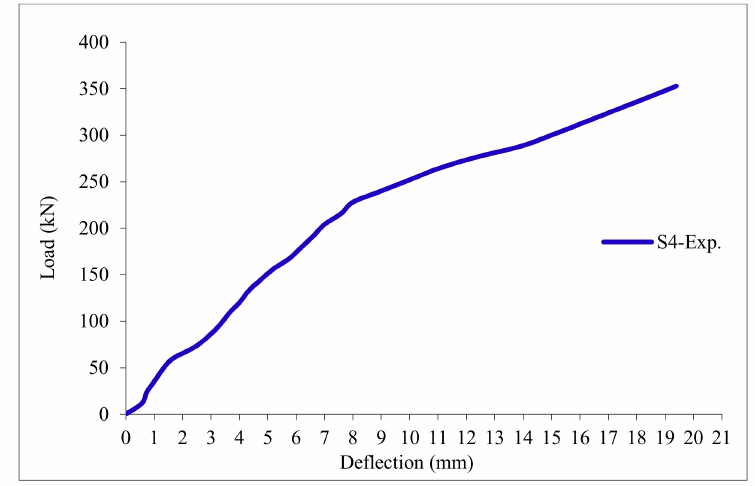
Figure 20. Load deflection curve for slab S4.